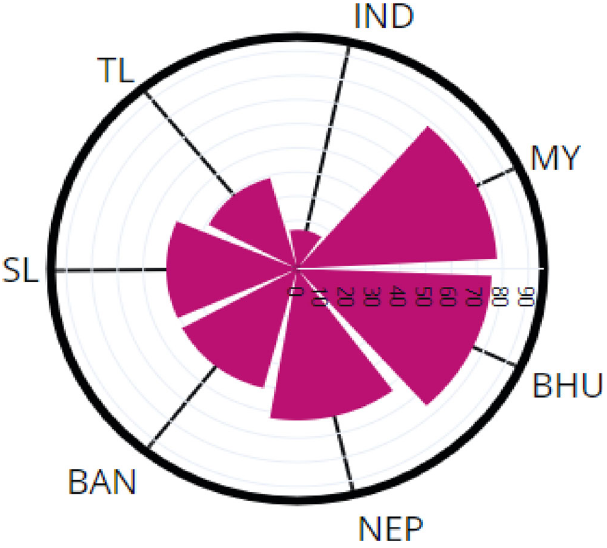
Figure 6. International collaboration publication percentage of BIMSTEC countries. India (IND), Thailand (TL), Bangladesh (BAN), Sri Lanka (SL), Nepal (NEP), Myanmar (MY), Bhutan (BHU).